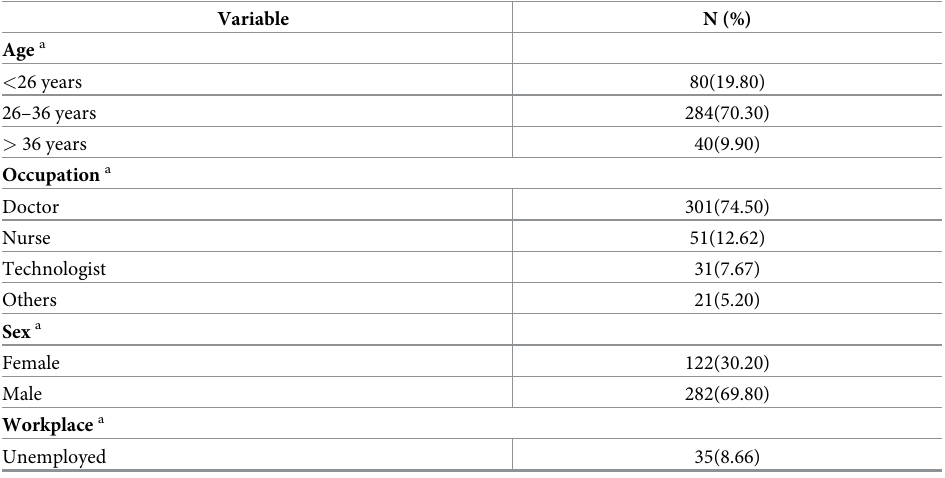
Table 1. Baseline characteristics of study